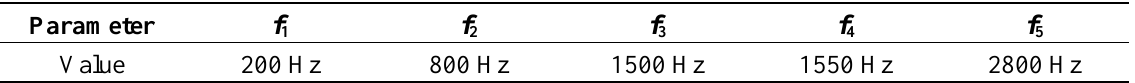
Table 2. Parameters of the selected characteristic